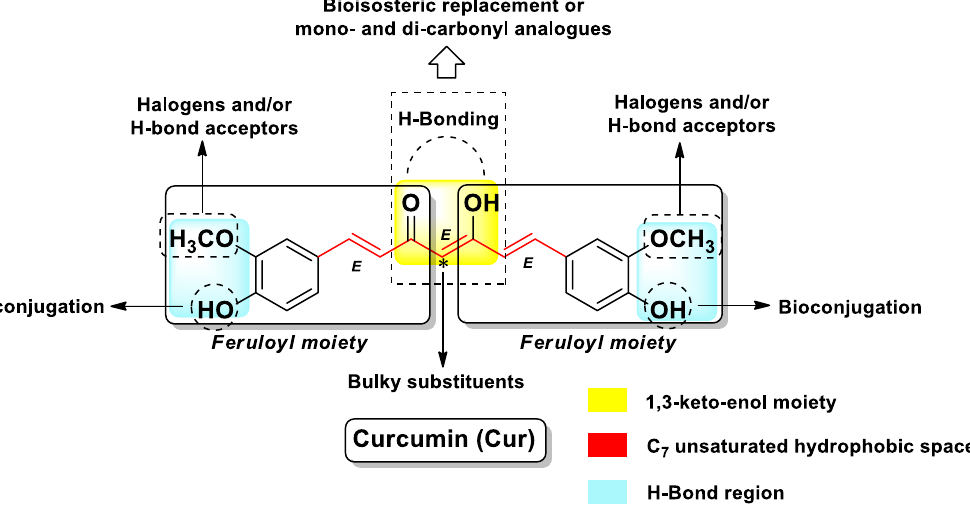
Figure 1. Chemical features and SAR insights of Cur.